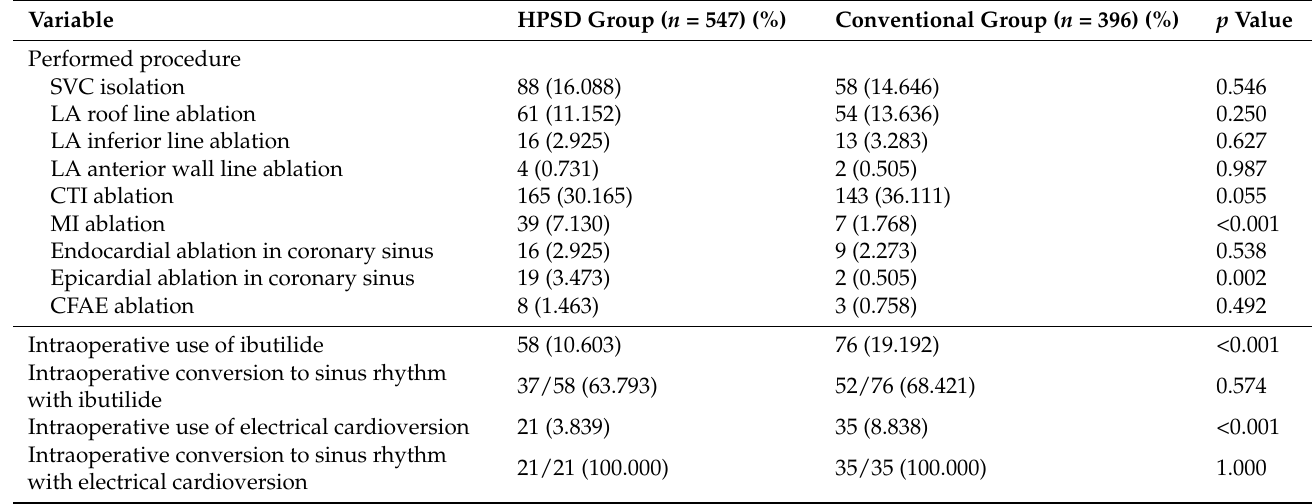
Table 2. Procedure characteristics.